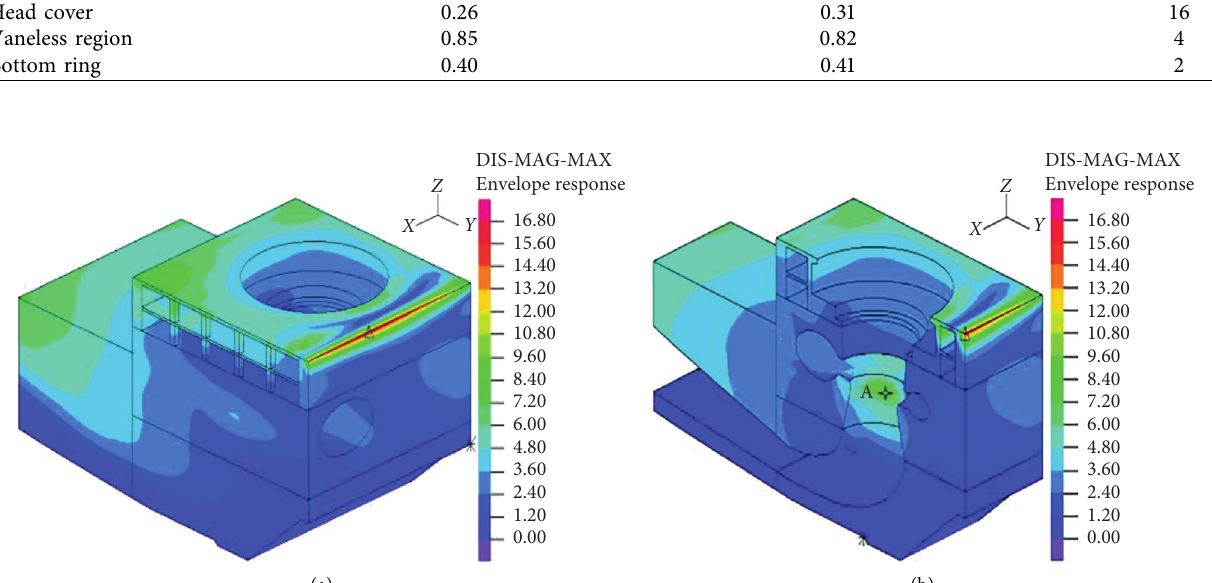
Δ H / H with 97% degree of confidence (%) Simulation results In-site data